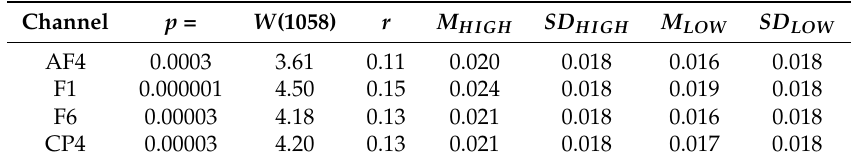
Table 4. Eyes-Closed (EC) setting. Channel-wise paired Wilcoxon rank sum tests for four channels (AF4, F1, F6, and CP4) in which significantly higher distributed TEs were associated with HIGH stress-susceptible group. p , W , and r refer to p -value, test-statistics, and the effect size for Wilcoxon rank sum tests. M and SD are the mean and standard deviation of these channels’ distributed TE values for HIGH and LOW stress-susceptible groups. The subscripts to M and SD mark the two groups. p =